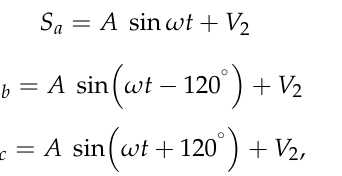
Figure 6. Proposed TSCMPWM modulating signal generation technique: ( a ) step by step procedure and ( b ) flowchart/al- gorithm.